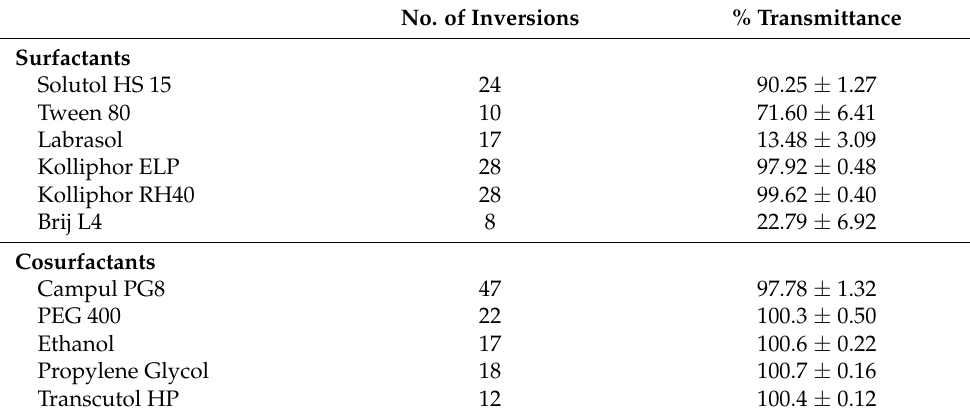
Figure 2. Solubility of AC1497 in various oils ( A ), surfactants ( B ), and cosurfactants ( C ) (mean ± SD, n = 3).